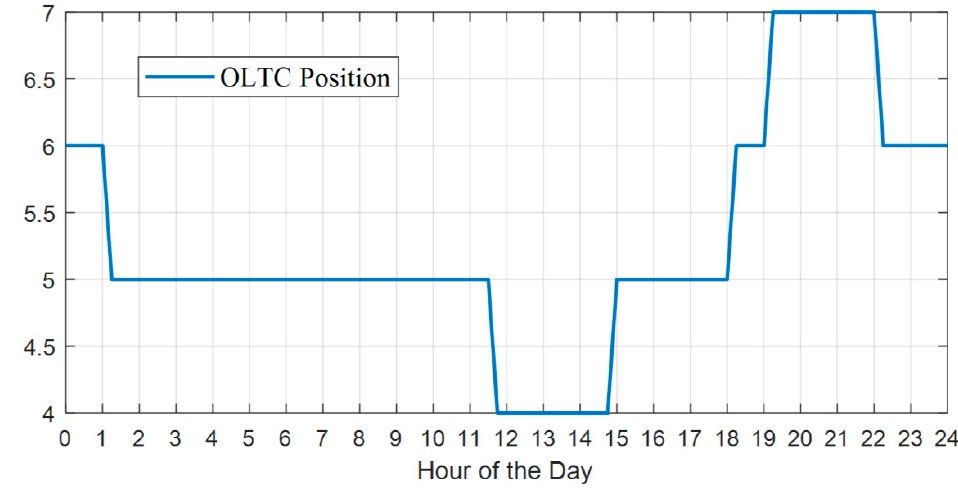
Figure 15. On Load Tap Changer (OLTC) position changes.